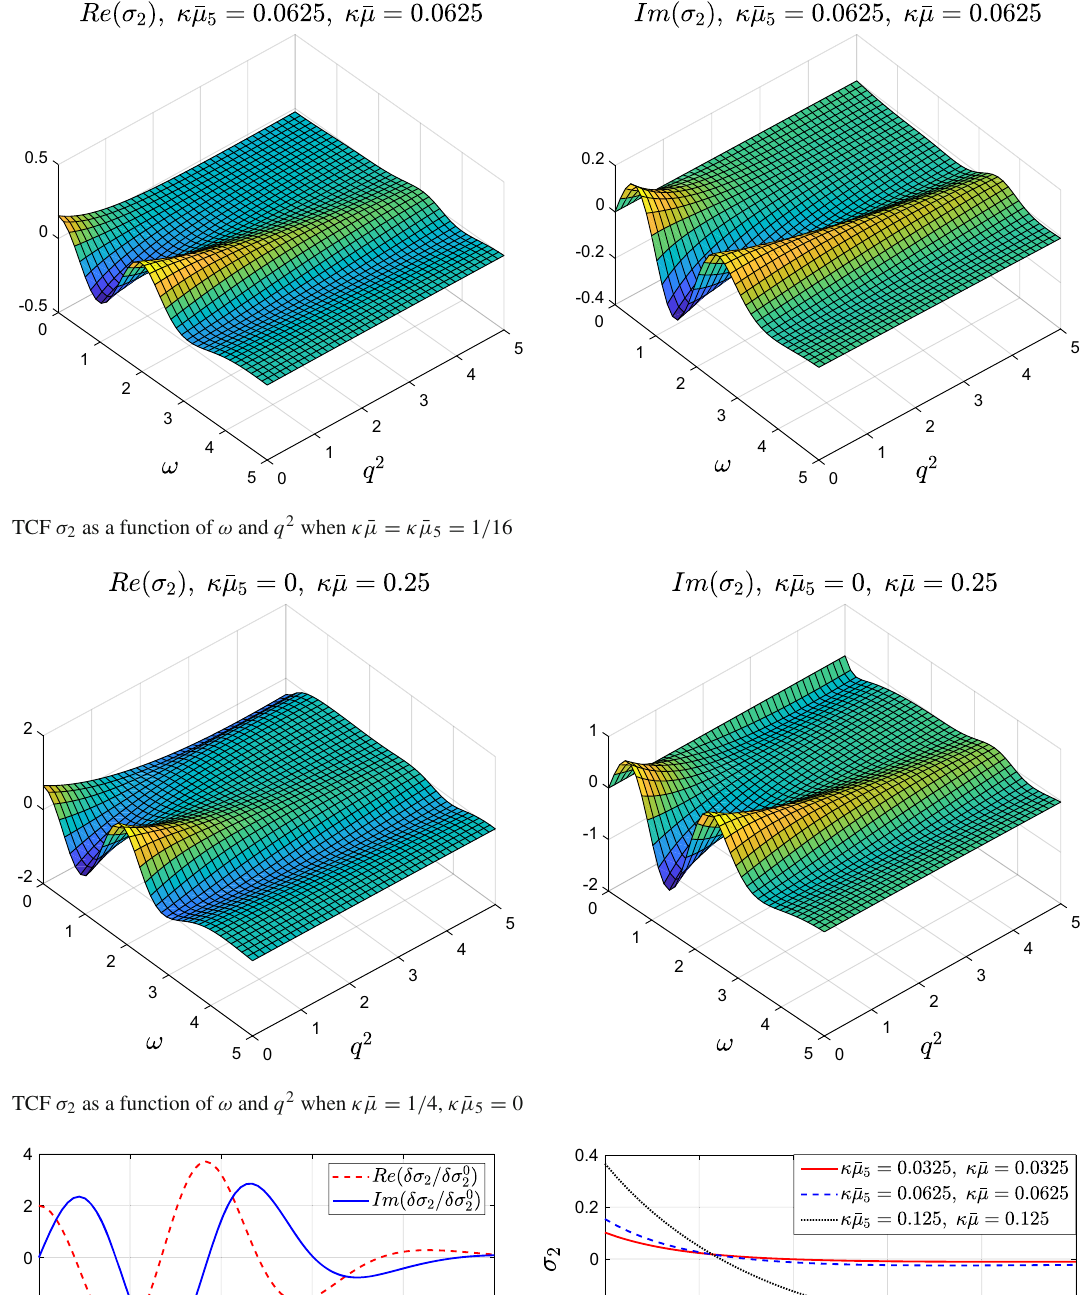
when q = 0 (left); q 2 -dependence of σ 2 when ω = 0 2